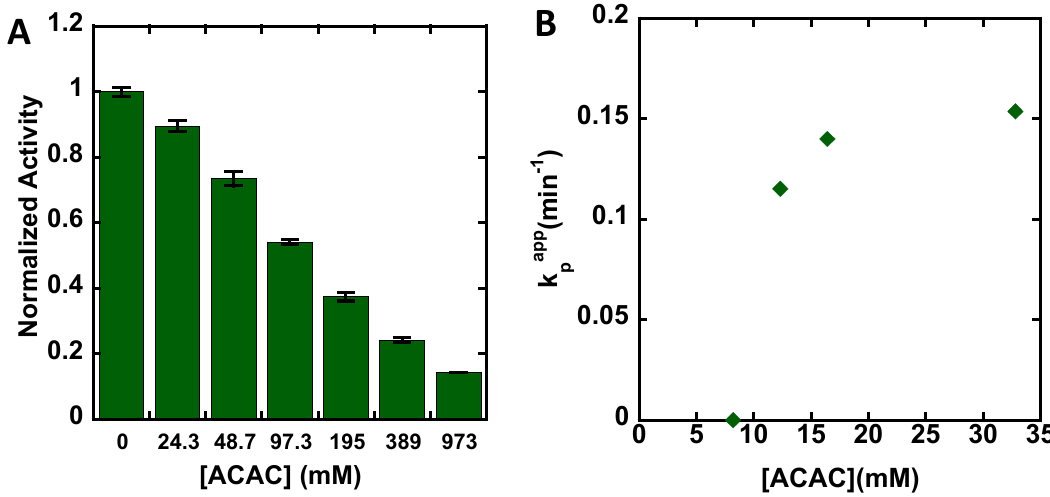
Figure 8. ( A ) Relative rate of enzymatic activity, as a function of ACAC loading, measured by the reaction of aminoantipyrine and phenol, normalized to activity at no ACAC loading; ( B ) Apparent polymerization rate (k papp ) under the conditions: [DMAm] 0 :[PAETC] 0 :[ACAC] 0 :[H 2 O 2 ] 0 = 100:1: X :1.7, [DMAm] = 170 mM, [HRP] = 0.71 mg/mL in 4.2 mL of pH = 5.5, 20 mM acetate buffer at 25 °C.